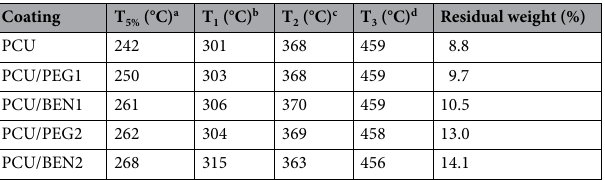
Table 1. Characteristic data obtained from TG/DTG curves of coatings. a Temperature for 5% mass loss, b– d Temperature for the mass loss rate.